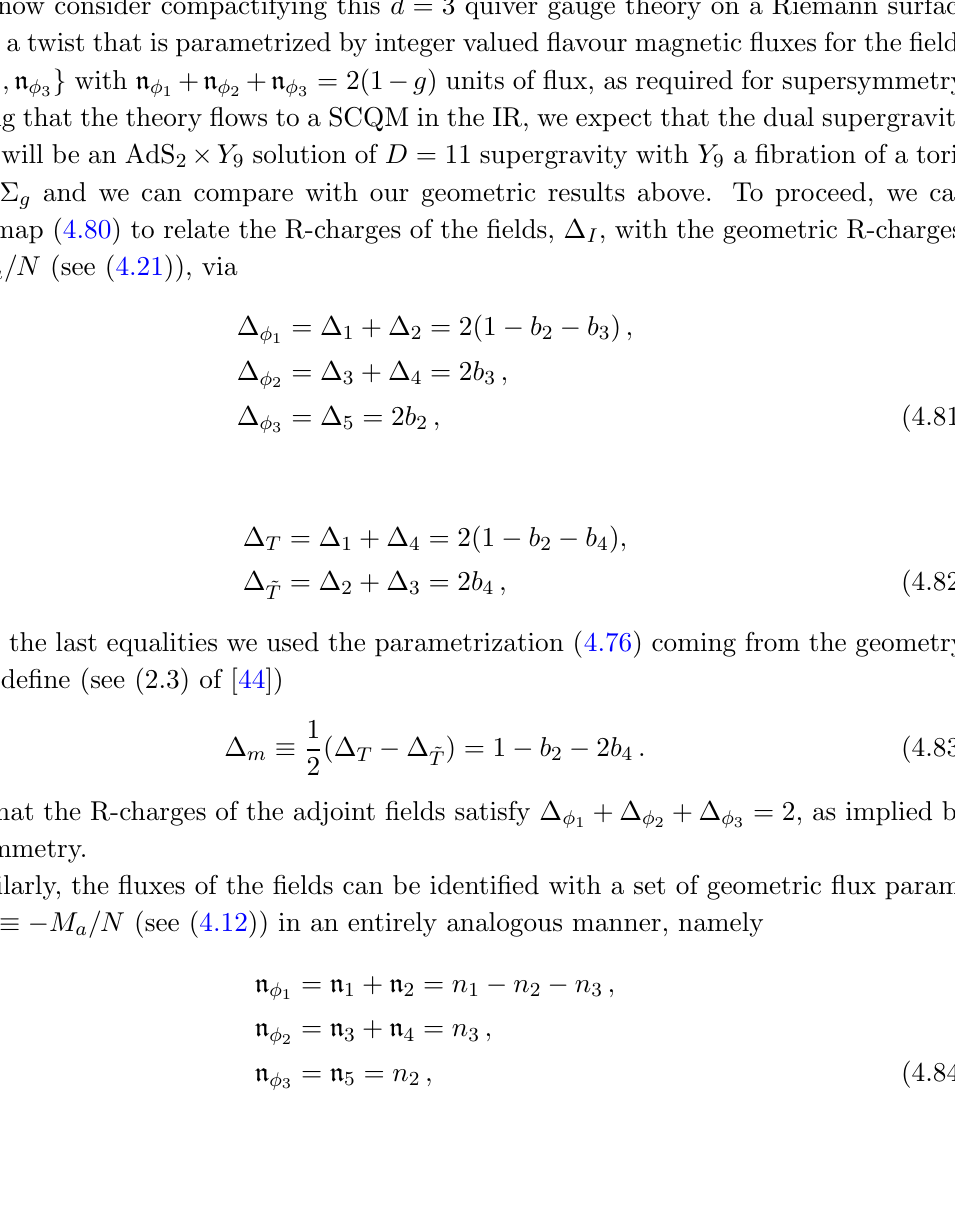
Table 1 . Relation between toric data (4.120) and perfect matchings for the C (cid:2) Conifold singularity